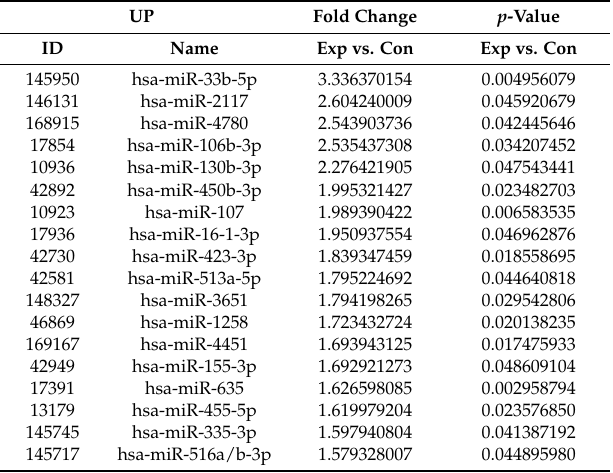
Figure 1. Heat maps show expression profiles of miRNAs and co-expressed target mRNAs. Each row represents a sample and each column represents a miRNAs or mRNA. The red strip represents high relative expression and the green strip represents low relative expression. T represents the bladder cancer group, and N represents the normal control group. Each group contains four different samples. ( A ) Heat map of differentially expressed miRNAs (fold change ≥ 1.5 and p -value < 0.05); and ( B ) Heat map of co-expressed target mRNAs from the two most up- and the three most down-regulated miRNAs. Table 1. The 18 up-regulated miRNAs ranked by fold changes in microarray data.